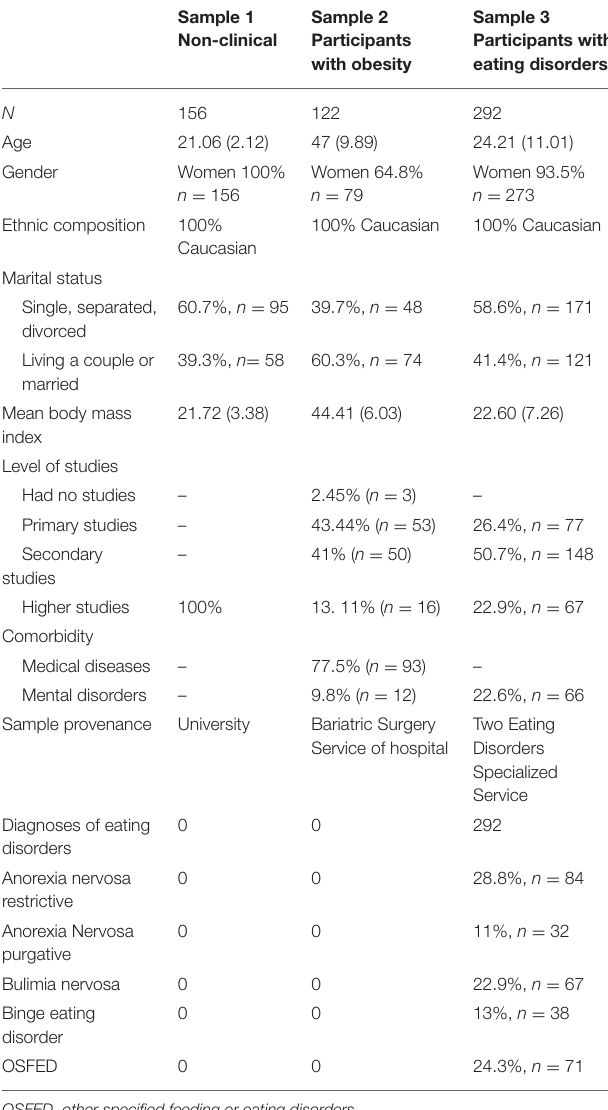
TABLE 1 | Demographic and clinical characteristics of the three